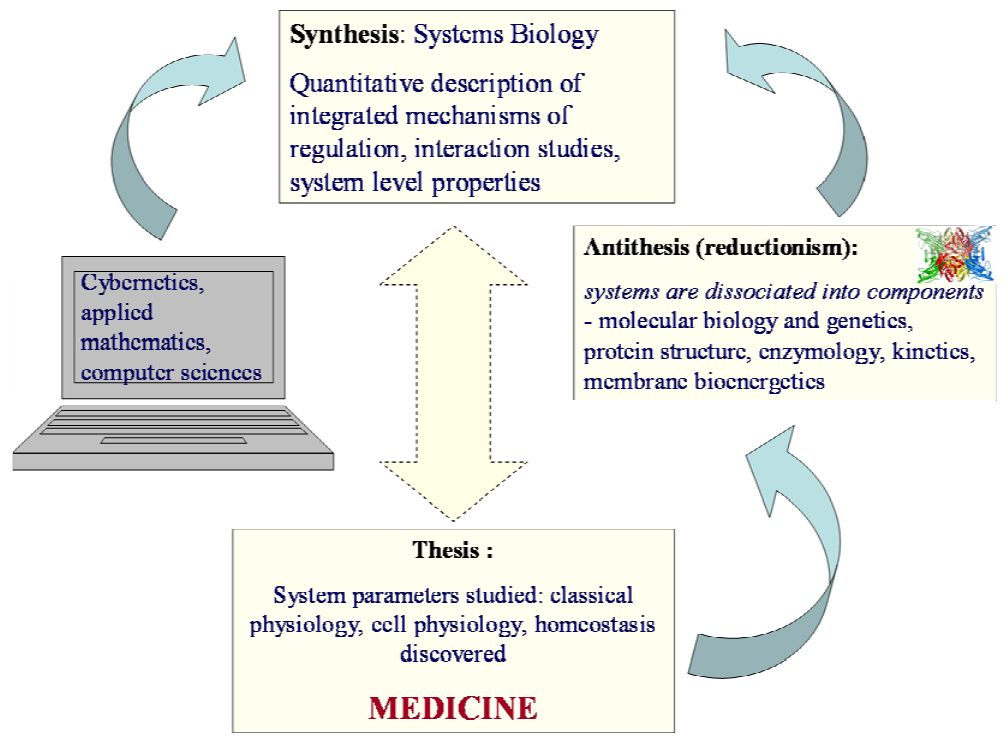
Figure 2. Presentation of development of biological sciences as Hegelian dialectic movement. In times of Claude Bernard, the problems of experimental physiology and medicine were formulated from the point of view of the theory of homeostasis at the organ level. To solve these problems, the components of the cell (proteins, genes, mitochondria etc.) were studied in the isolated state. In Systems Biology, these components are again studied in their interaction within the intact systems of